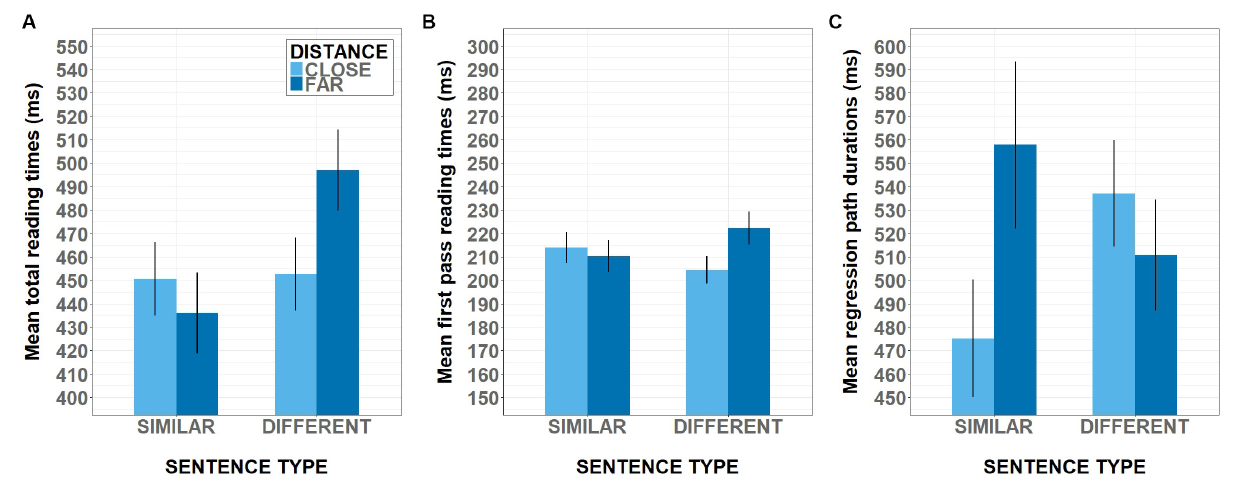
FIGURE 2 | Mean reading times at regions with reliable interaction effects between spatial distance and semantic similarity. The x -axis plots the two sentence types (expressing similarity vs. difference) for each level of distance (far vs. close). (A) Shows mean total reading times at adjective (ADJ) in Experiment 1. (B) Shows first pass reading times at the second noun phrase region (NP2) in Experiment 2. (C) Shows regression path duration at the adjective (ADJ) in Experiment 2. Error bars plot the within-subjects adjusted standard error of the